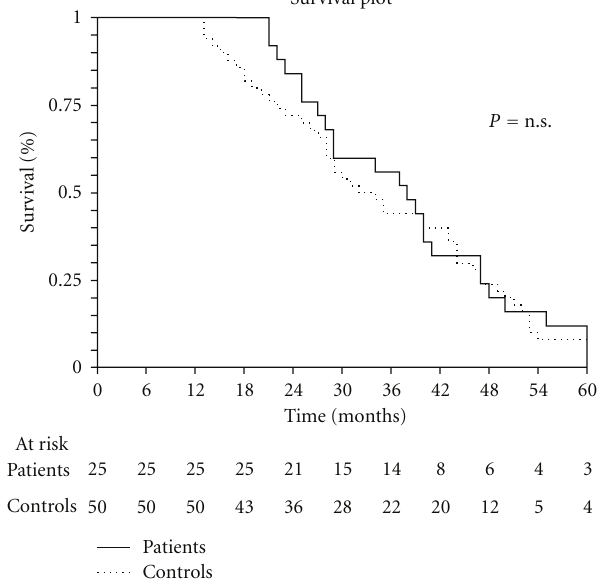
Figure 2: Disease free survival.